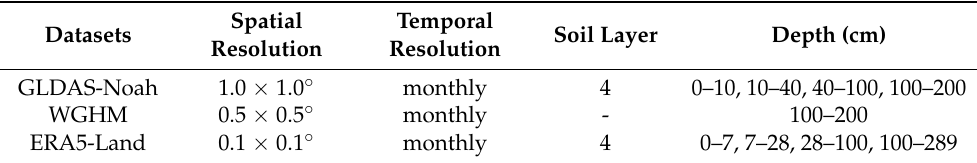
Table 1. Summary of soil-moisture products from GLDAS, WGHM, and ERA5-Land. Datasets